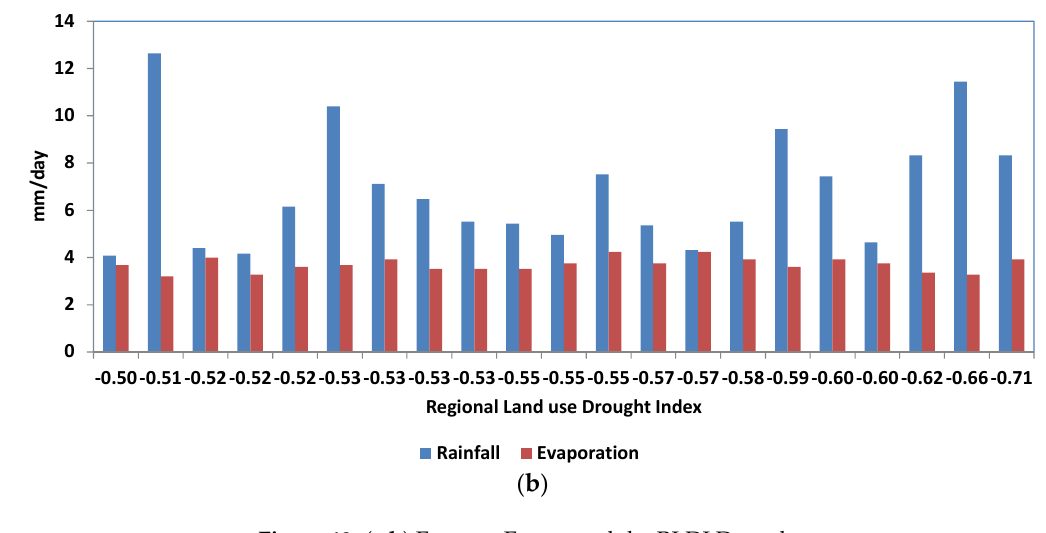
Figure 13. ( a , b ) Extreme Events and the RLDI Drought.